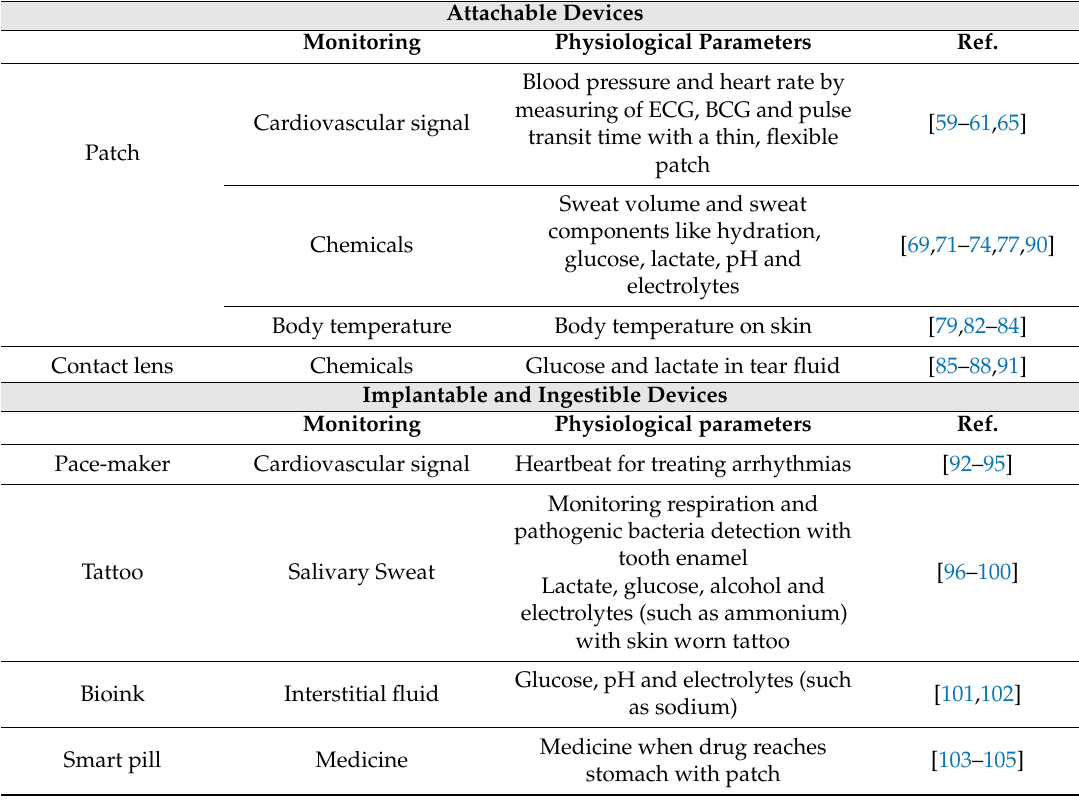
Table 3. Summary of the attachable, implantable and ingestible devices for health